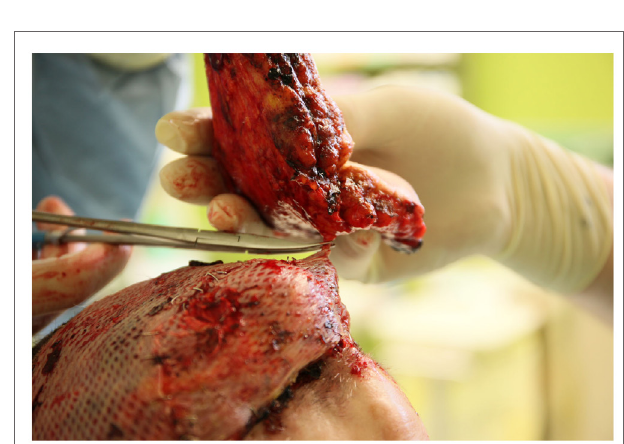
FiGURe 5 | Removal of the skin paddle after ligation and severing of the perforating vessels .